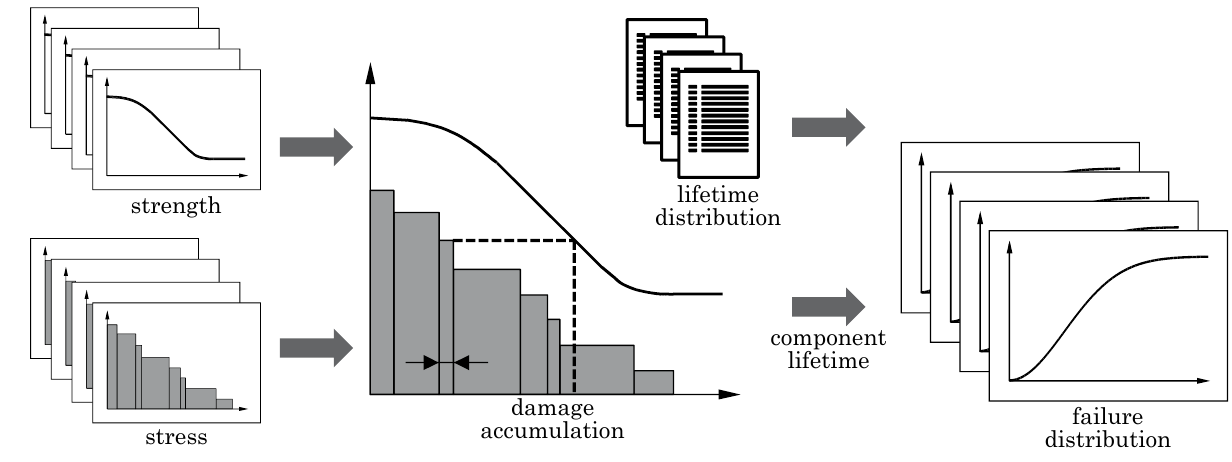
Figure 4: Process of damage accumulation for